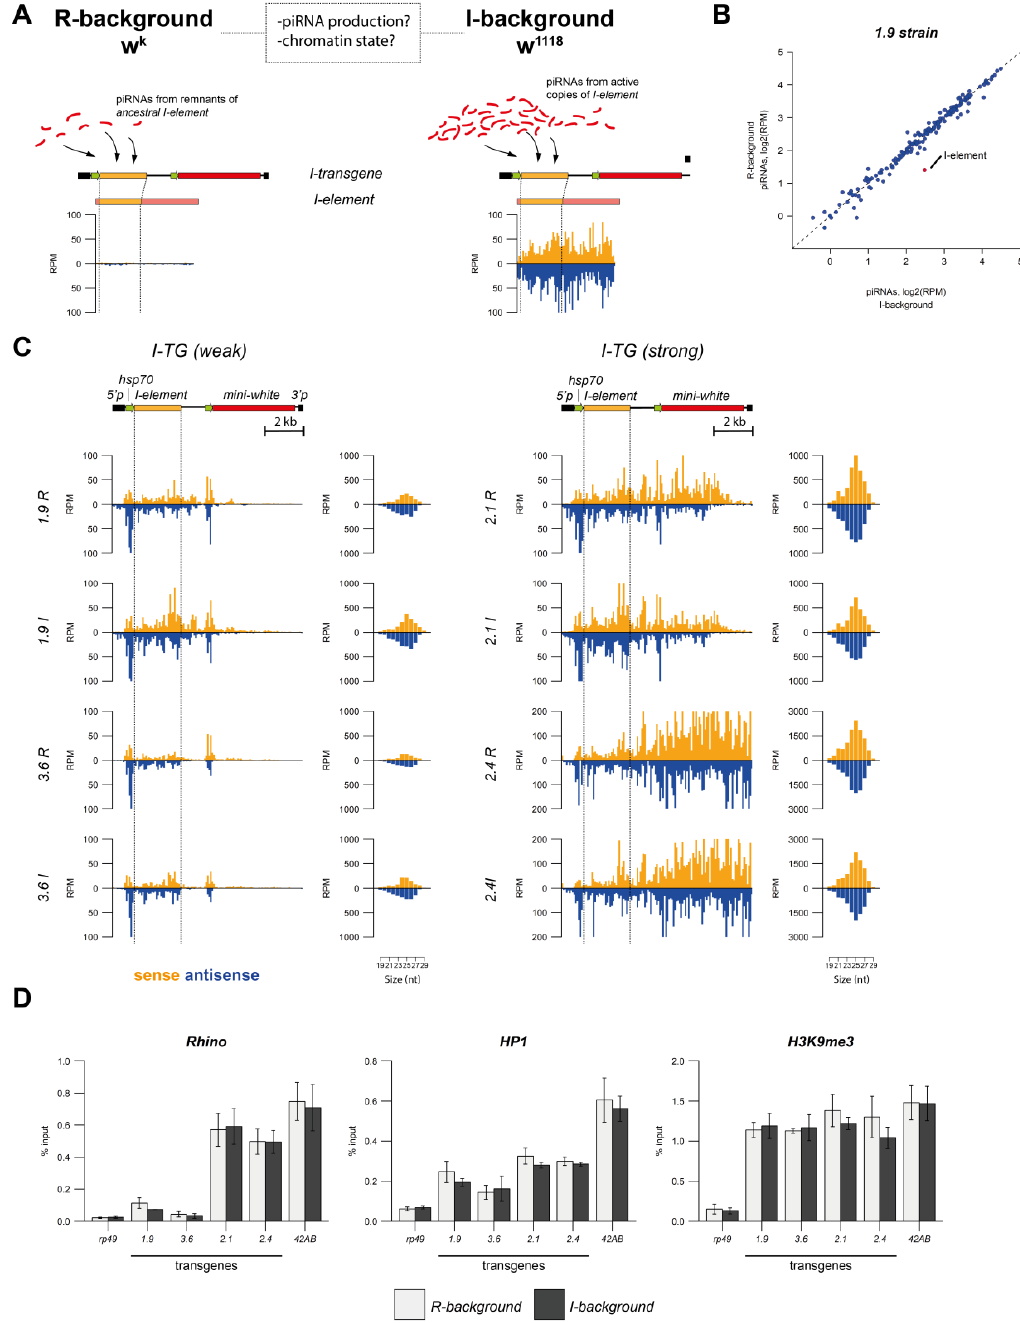
Figure 3. The small RNA production and chromatin structure of the I -transgenes are similar in the R and I genetic backgrounds. ( A ) The scheme of the experimental design is shown. The small RNA distribution along the canonical I -element in w K (Reactive (R) strain) and balanced w 1118 ; CyRoi /+ ;TM3, Sb Ser /+ (Inducer (I) strain, designated as w 1118 ) is shown below the scheme. ( B ) The scatter plot shows normalized Transposable Element (TE)-specific piRNAs (24–29 nt reads considered, 0-3 mismatches allowed) in ovaries of 1.9 w R and 1.9 w I strains. ( C ) Normalized numbers of ovarian small RNAs (19–29 nt) mapped to the indicated transgenic constructs placed in R or I genetic backgrounds (brown—sense; blue—antisense; no mismatches allowed). The scheme of the I-TG transgene is shown above. ( D ) HP1, H3K9me3, and Rhi occupancy at the I-TG transgenes in R and I genetic backgrounds. The rp49 and 42AB regions are used as negative and positive controls,